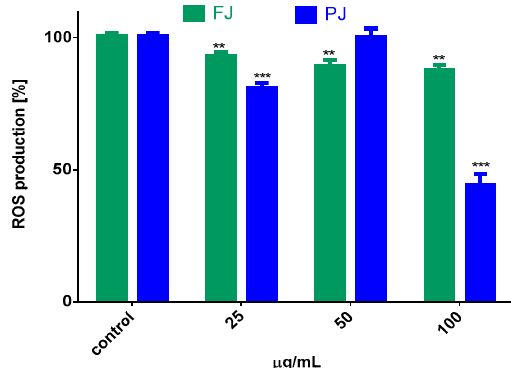
Figure 7. The influence of V. opulus FJ and PJ at IC 0 dosage on intracellular ROS generation in Saos-2 cells after 8 days of exposure, quantified with DCFH-DA assay; control cells were not exposed to any compound; values are means ± SEM, n ≥ 9; statistical significance was calculated versus control cells (untreated), ** p ≤ 0.01, *** p ≤ 0.001.